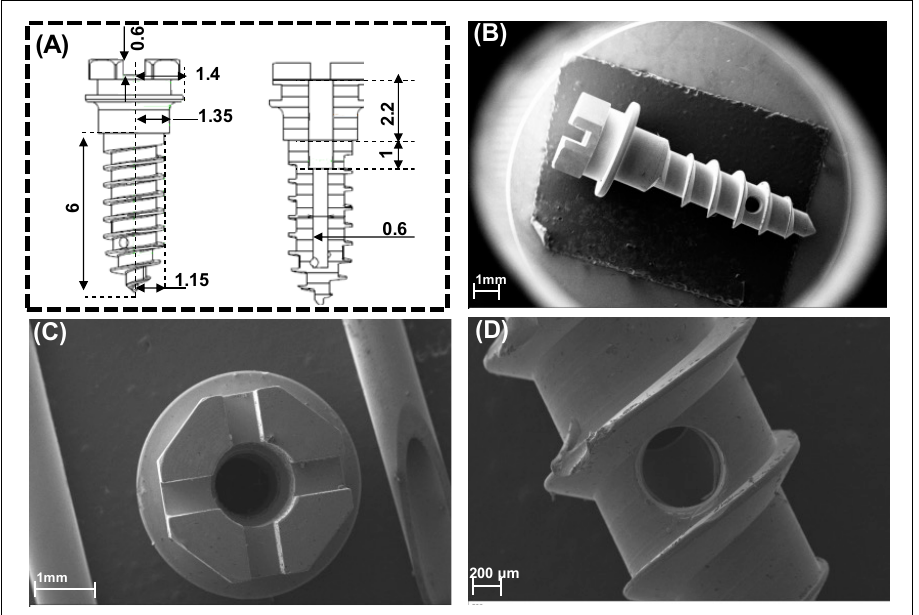
Figure 1. The Sydney Mini Screw (A) Front and section view dimensions (Unit: mm); (B) lateral port hole layout; (C) top view of the miniscrew head showing a custom-made chamber for internal threaded surface for 20-gauge needle connection; (D) Side view of one of the lateral port